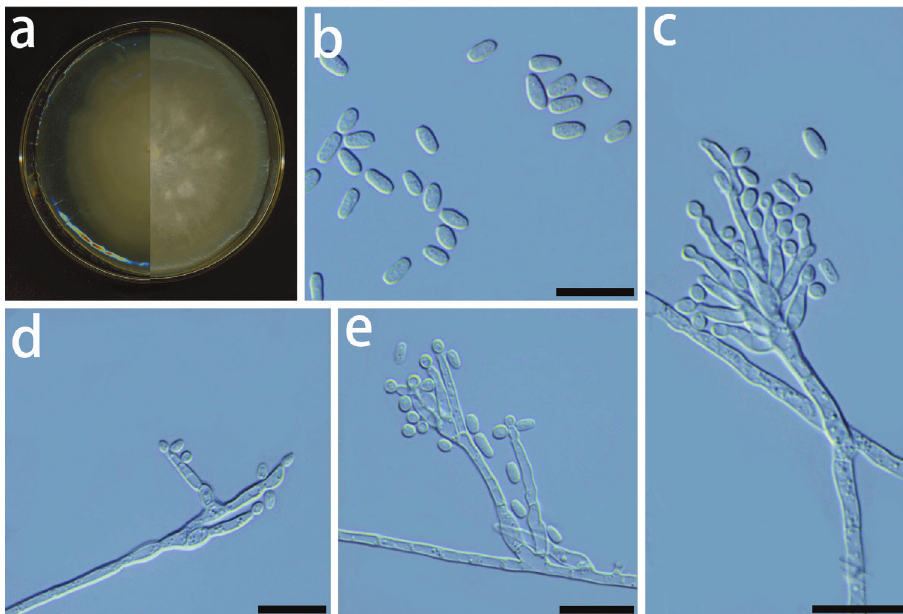
Figure 12. Morphological characters of asexual structures of Graphilbum niveum sp. nov. a left: seven- day-old culture on MEA; right: twenty-day-old culture on MEA b Conidia c-e conidiophores and co- nidia. – Scale bars: 10